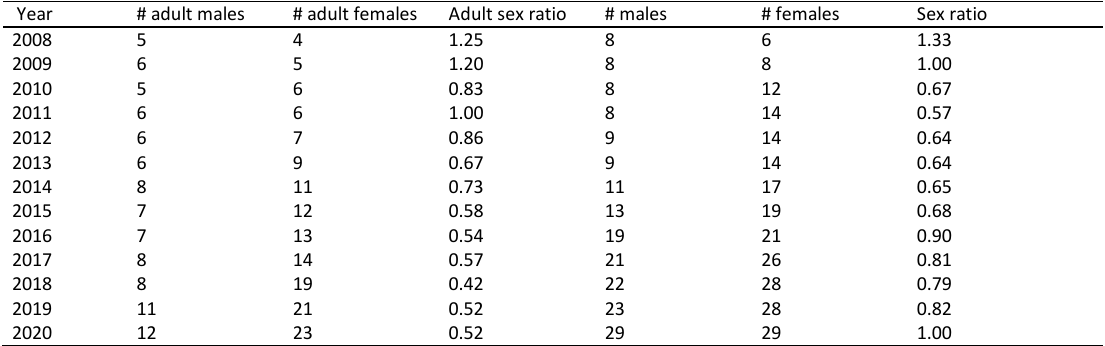
Table S7: Evolution of the sex ratio of the Pyrenean brown bear population from 2008 to 2020 among all individuals and among adult only. Year # adult males # adult females Adult sex ratio Sex